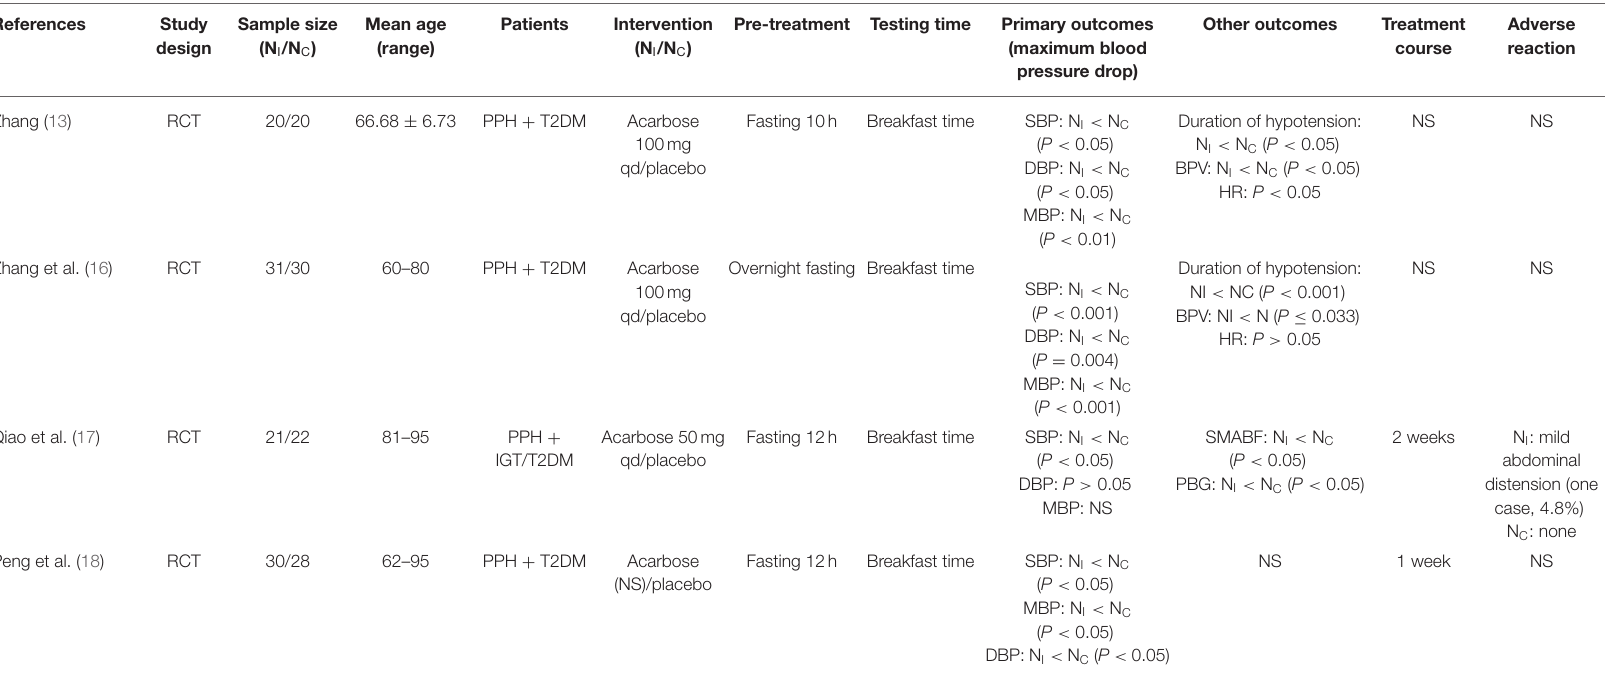
TABLE 1 | Characteristics of the included